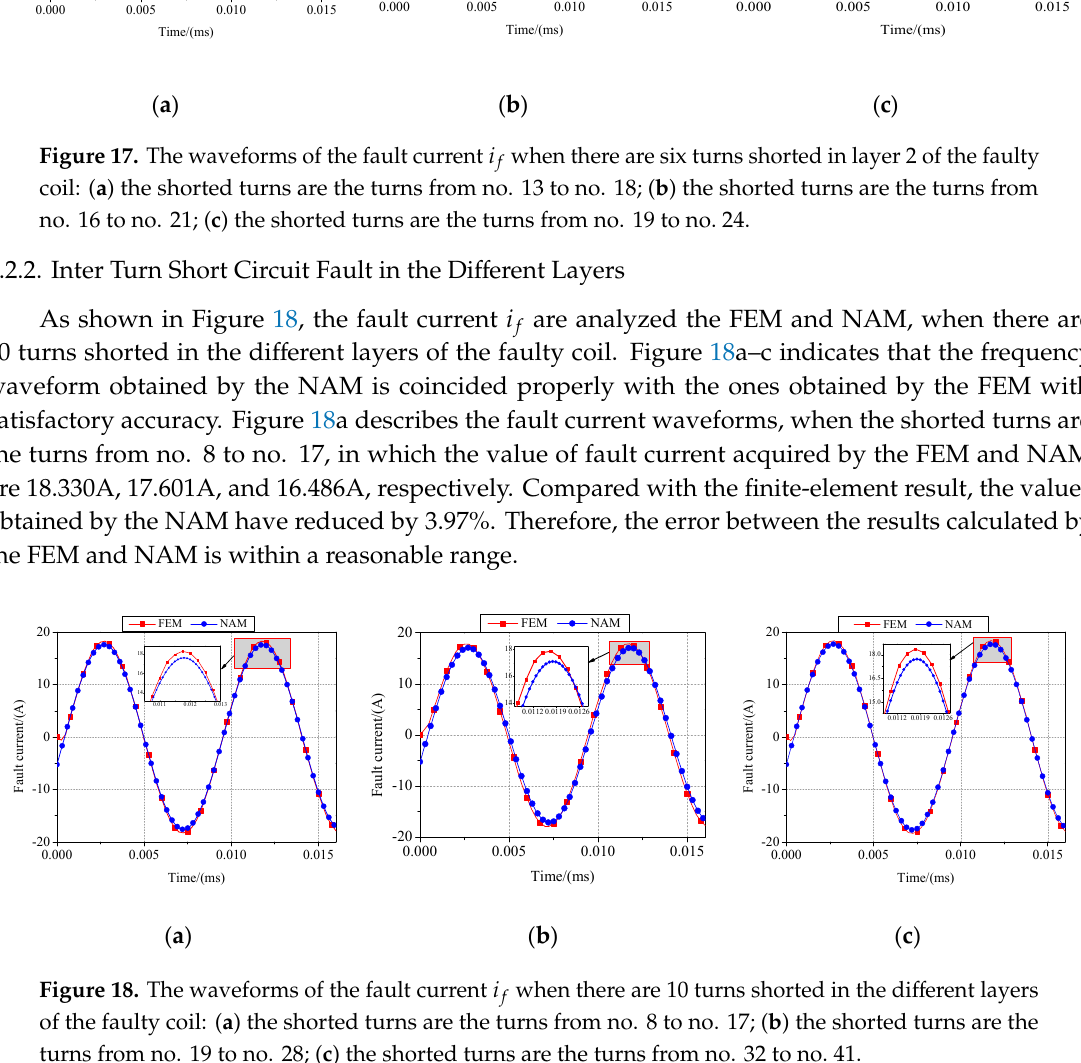
Figure 18. The waveforms of the fault current i f when there are 10 turns shorted in the different layers of the faulty coil : ( a ) the shorted turns are the turns from no. 8 to no. 17; ( b ) the shorted turns are the turns from no. 19 to no. 28; ( c ) the shorted turns are the turns from no. 32 to no. 41.